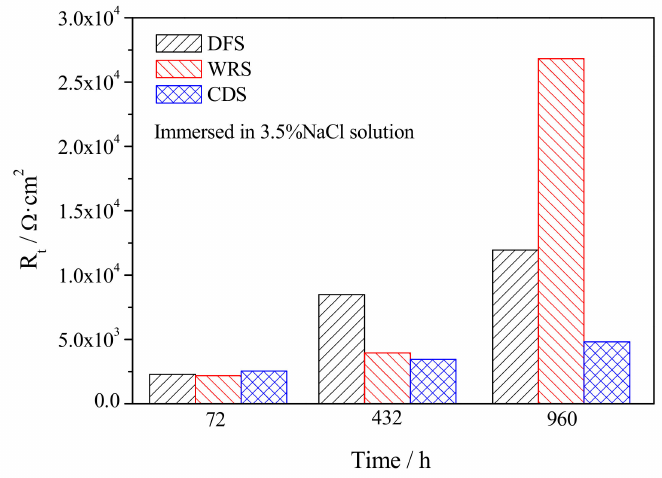
Figure 18. The R t evolution of di ff erent specimens with immersion